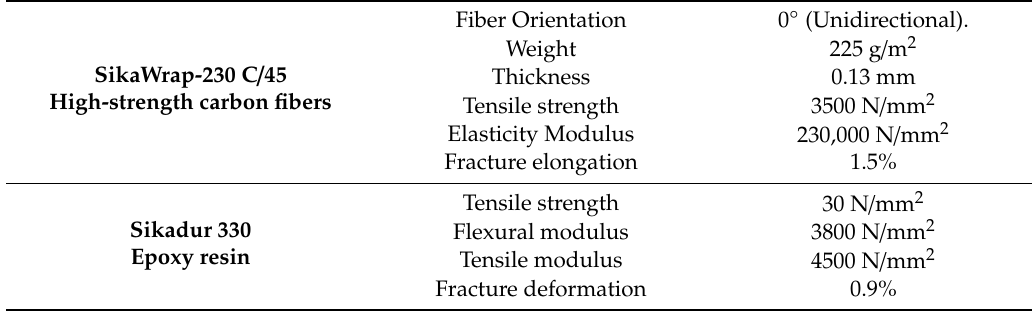
Table 2. CFRP laminates and epoxy adhesive properties.